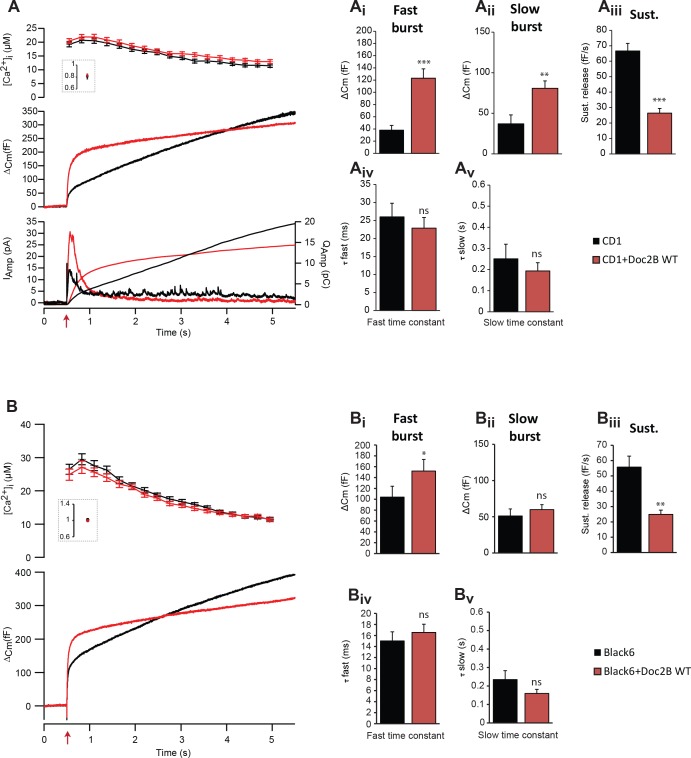
Overexpression of Doc2B in wild-type cells increases the burst size and decreases the sustained release.(A) Calcium uncaging experiments in CD1 mouse adrenal chromaffin cells (n = 20 cells) and CD1 cells overexpressing Doc2B (n = 20 cells). Top panel: intracellular [Ca2+] (mean ±SEM) obtained by microfluorimetry just after and (insert) before calcium uncaging (uncaging light for 1–2 ms at red arrow). Middle panel: Average capacitance traces of CD1 adrenal chromaffin cells (black trace) and CD1 cells overexpressing Doc2B WT (red trace). Bottom panel: amperometric measurements (average traces) from the same cells. The left ordinate axis represent the amperometric current, the right axis represent amperometric charged. (Ai) The amplitude of the fast burst (mean ±SEM) and the slow burst (Aii) were increased by overexpression Doc2B WT in CD1 cells (Mann-Whitney test, **p<0.01; ***p<0.001). The rate of the sustained component (Aiii) was strongly reduced by overexpressing Doc2B WT in CD1 cells (Mann-Whitney test, ***p<0.001). The fusion time constant of the fast (Aiv) and slow (Av) burst of release were unaffected. (B) Calcium uncaging experiments in Black6 mouse adrenal chromaffin cells (n = 25 cells) and Black6 cells overexpressing Doc2B (n = 26 cells). (Bi) The amplitude of the fast burst (mean ±SEM) was increased by overexpression of Doc2B WT in Black6 cells (Mann-Whitney test, *p<0.05) while the slow burst (Bii) was unchanged. In Black6 mouse chromaffin cells, the sustained rate was also dramatically reduced by overexpressing Doc2B WT (Mann-Whitney test, **p<0.01) and the fast (Biv) and slow (Bv) burst time constants were unaffected.